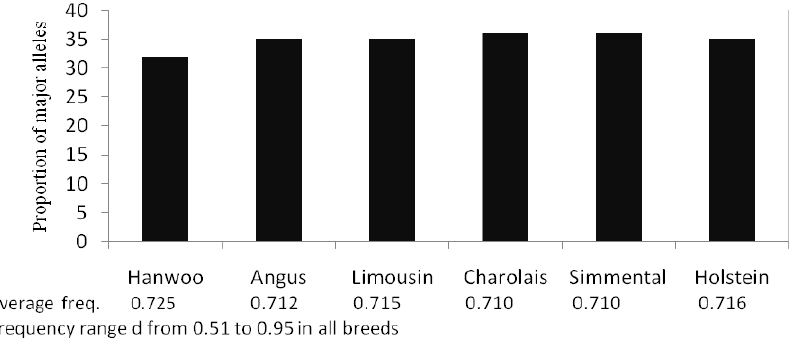
Figure 3. Proportion of major alleles and their corresponding average allele frequencies for each cattle